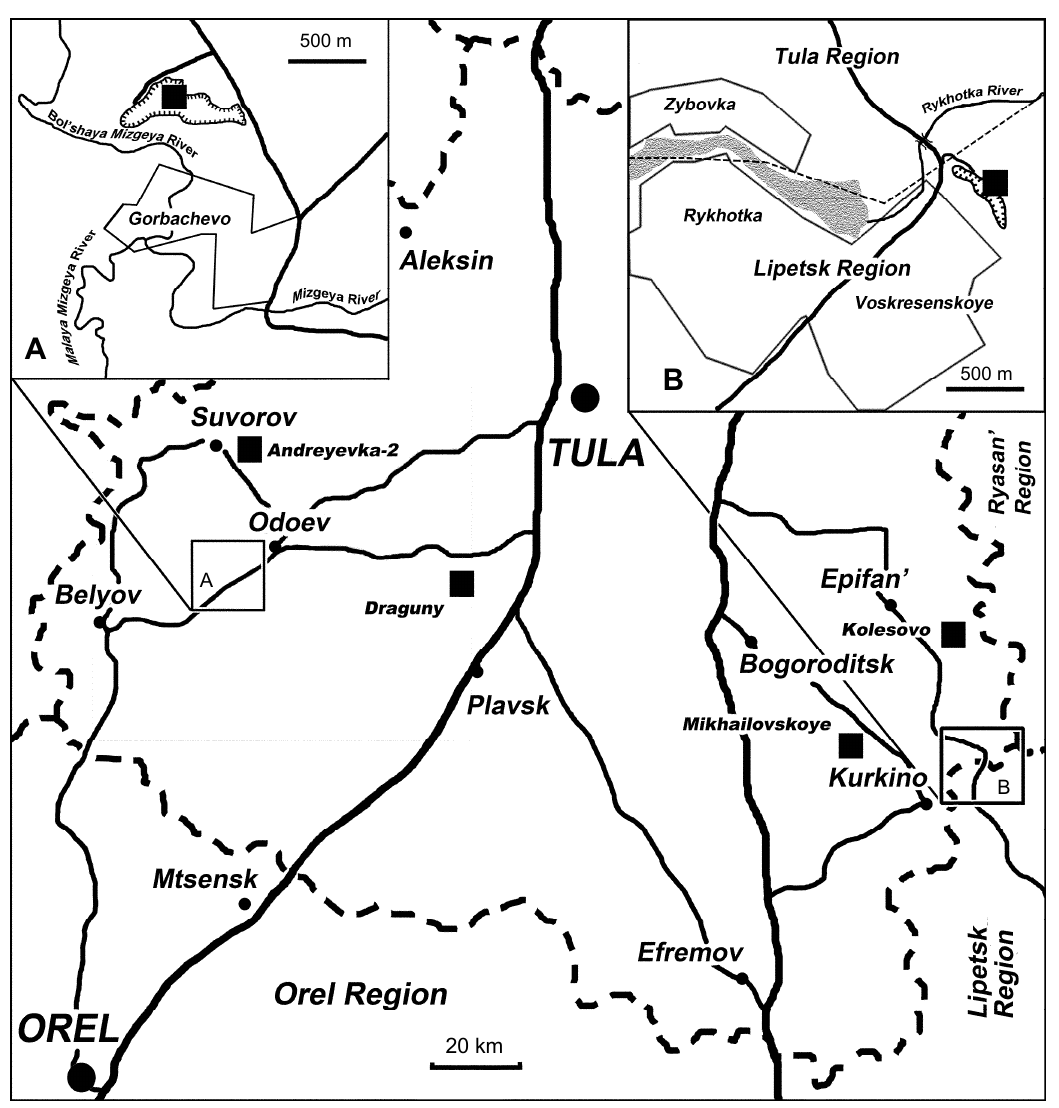
Fig. 1. Vertebrate localities of the Khovanshchinian RS (lower uppermost Famennian, Upper Devonian) in Central Russia. A , position of the Gorbachevo quarry; B , position of the Voskresenskoye